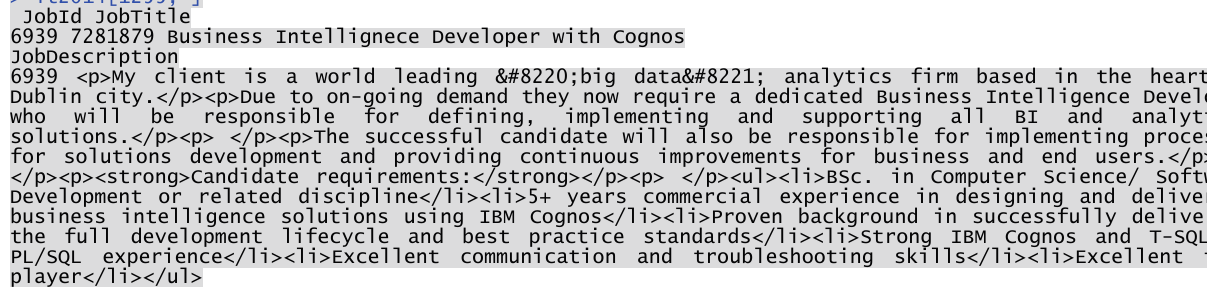
Figure 1. Sample record from the IT dataset.